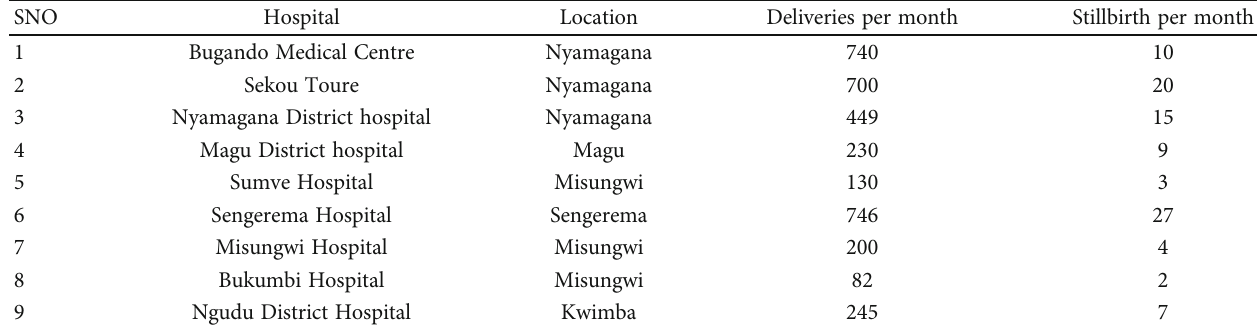
Table 1: Summary of hospitals involved in this study.